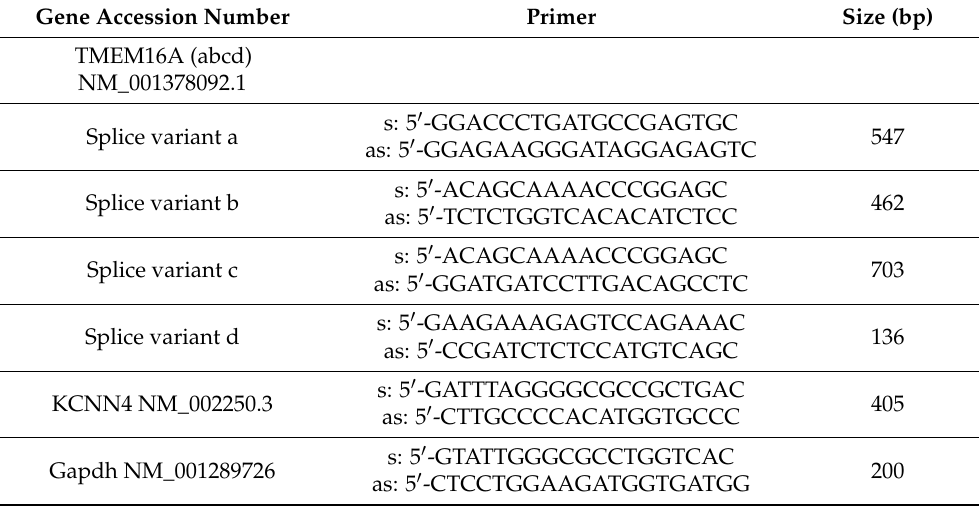
Table 1. Primers for